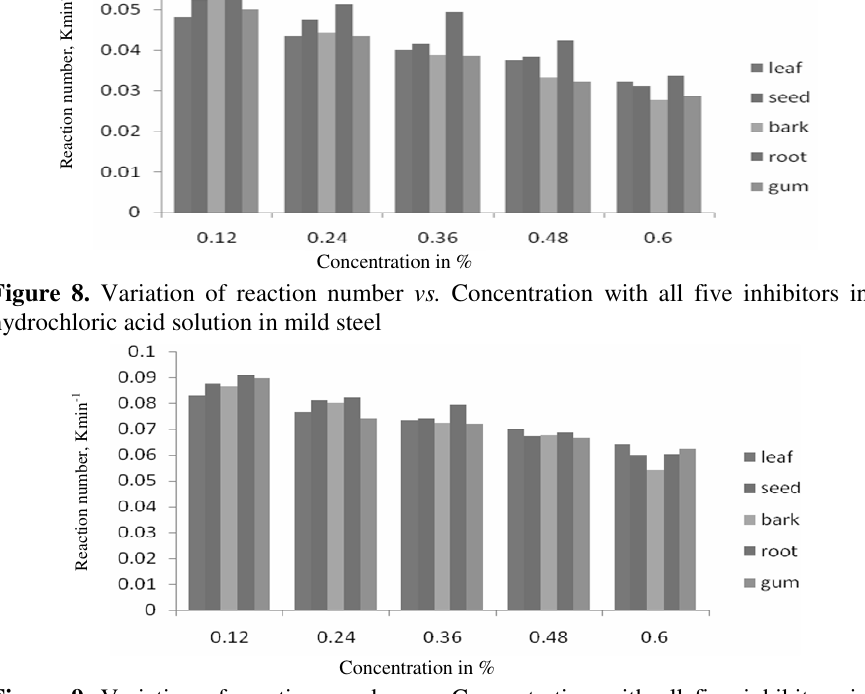
Figure 9. Variation of reaction number vs. Concentration with all five inhibitors in 5 N hydrochloric acid solution in mild steel Langmuir adsorption